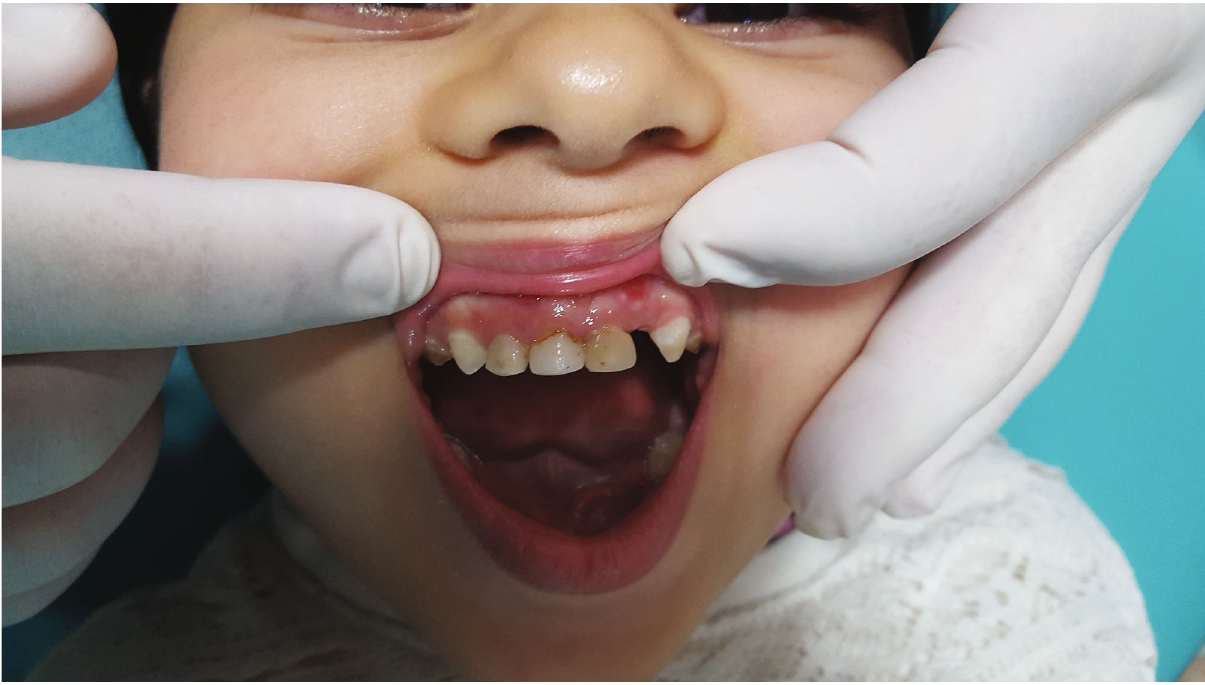
Figure 1: Final coronal restoration.